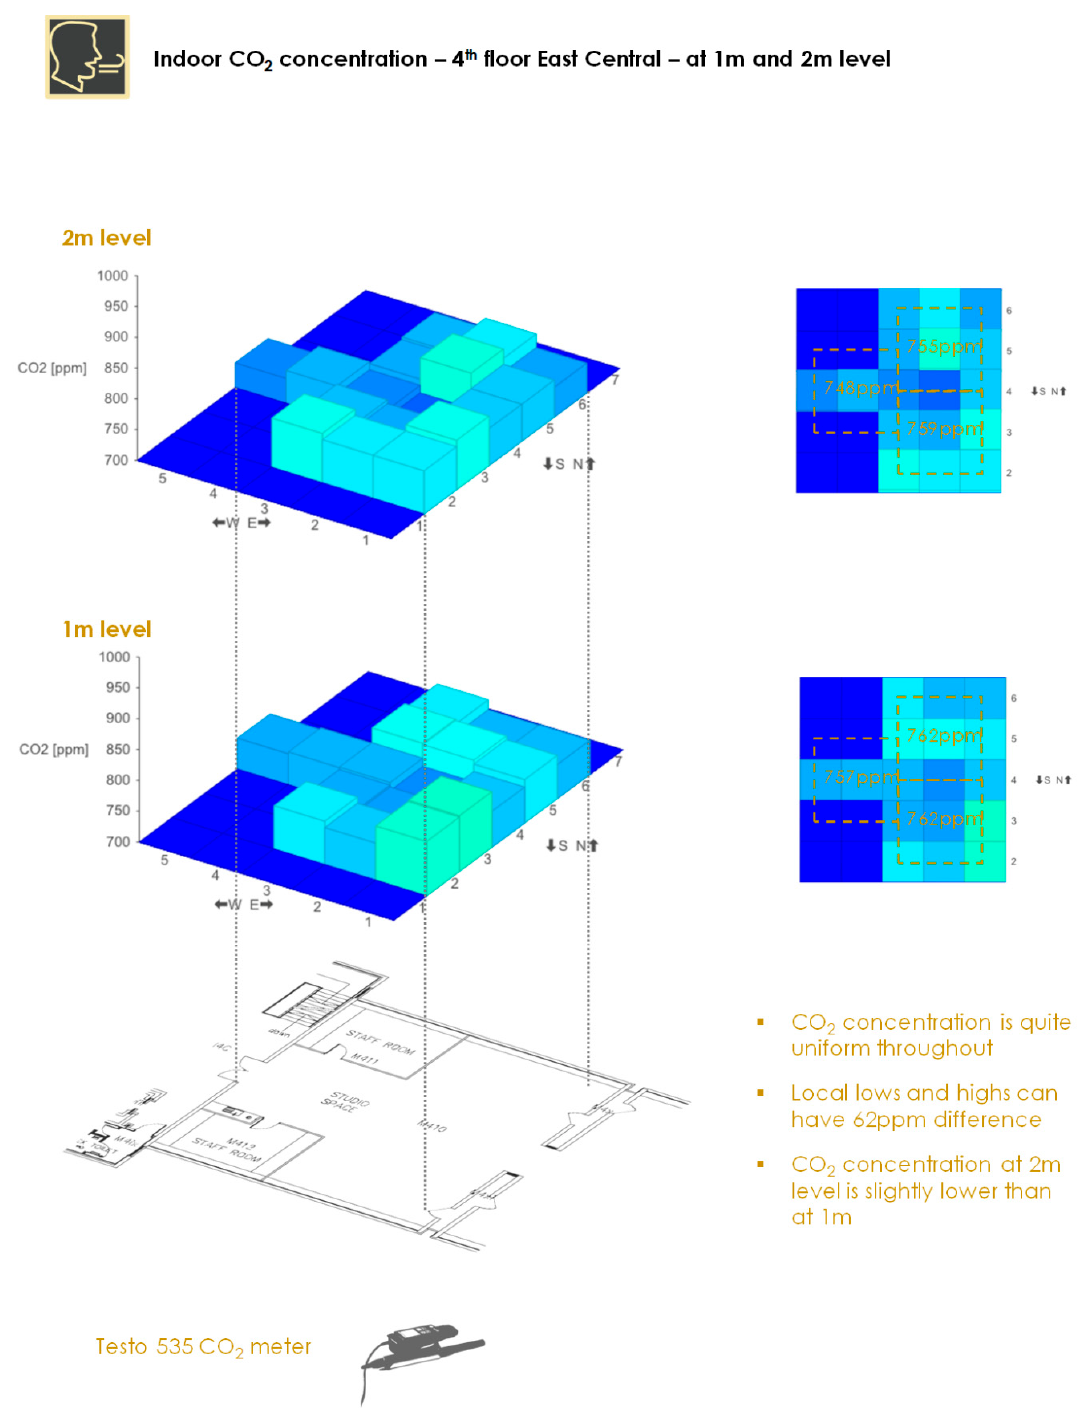
Figure A4. Variations of Indoor CO 2 levels at the 4th floor studio spaces (source: spot measurements plotted by the author; an icon has been used in this figure retrieved from Flaticon.com) [40].